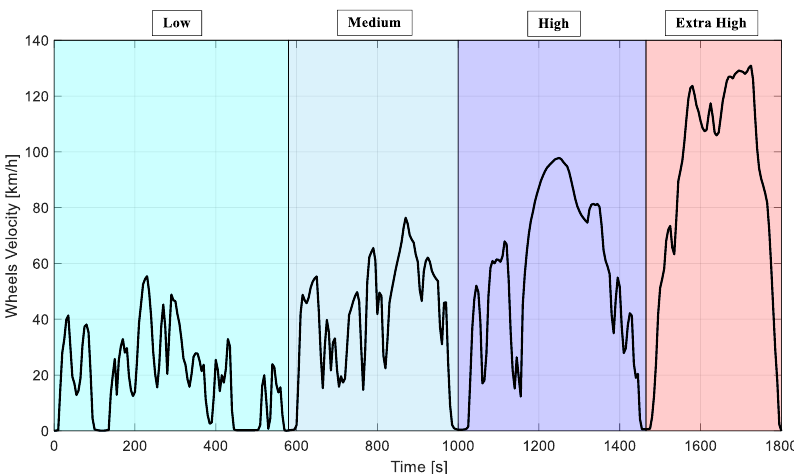
Figure 6. Worldwide harmonized Light-duty vehicles Test Cycles (WLTC) for passenger vehicles with high power-to-weight ratio.